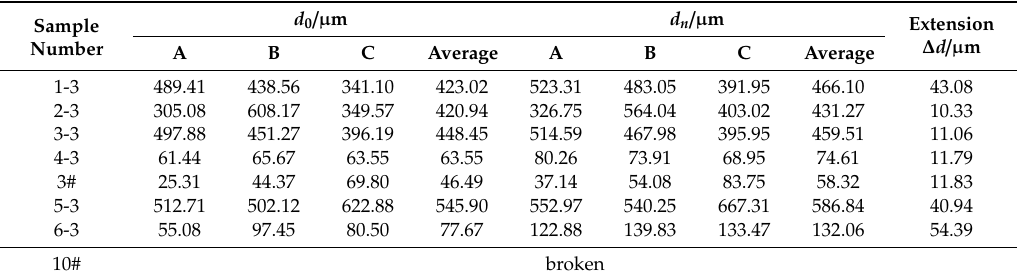
Table 2. Fissure widths of coal samples under varied confining pressures after 3 cycles of liquid nitrogen cold